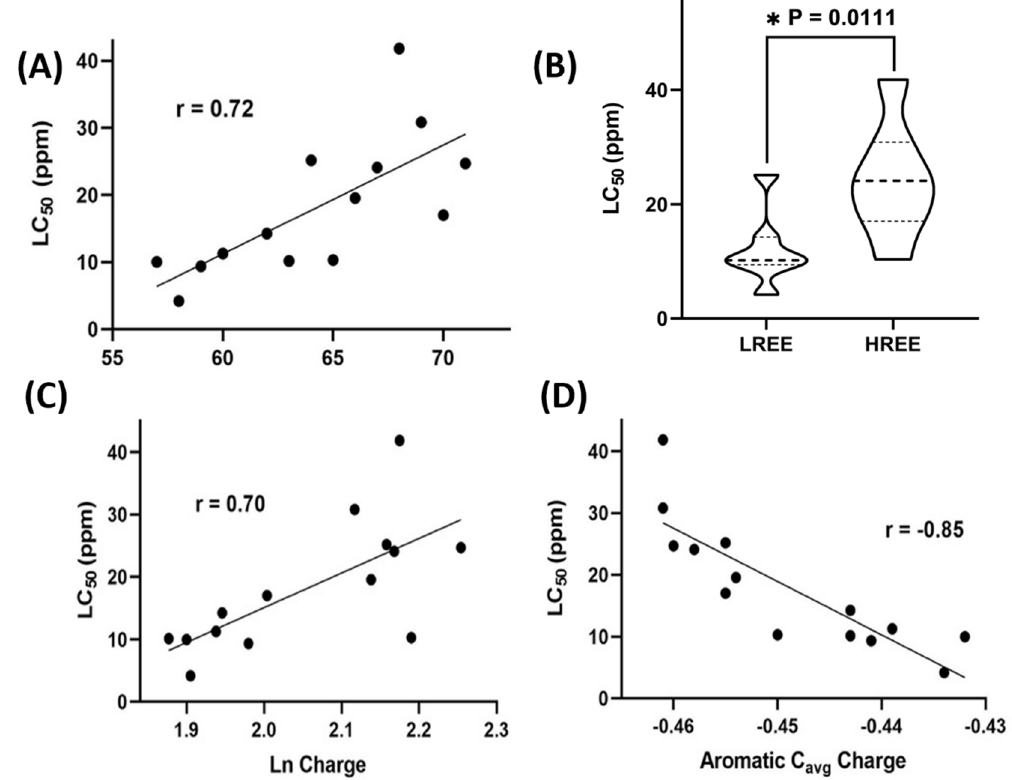
Figure 4. Correlations of properties of the Lanthanides complexes to the acute toxicity of fourteen Lanthanides. ( A ) The linear regression analysis showed a significant correlation between LC 50 and Lanthanide’s atomic numbers with r = 0.72. ( B ) A violin plot shows a statistical difference between the two LC 50 of LREE and HREE ( p = 0.0111). ( C ) The linear regression analysis showed a significant correlation between LC 50 and Lanthanide’s Milliken charge with r = 0.70. ( D ) The linear regression analysis showed the most significant correlation between LC 50 and the aromatic C avg charge with r = − 0.85.